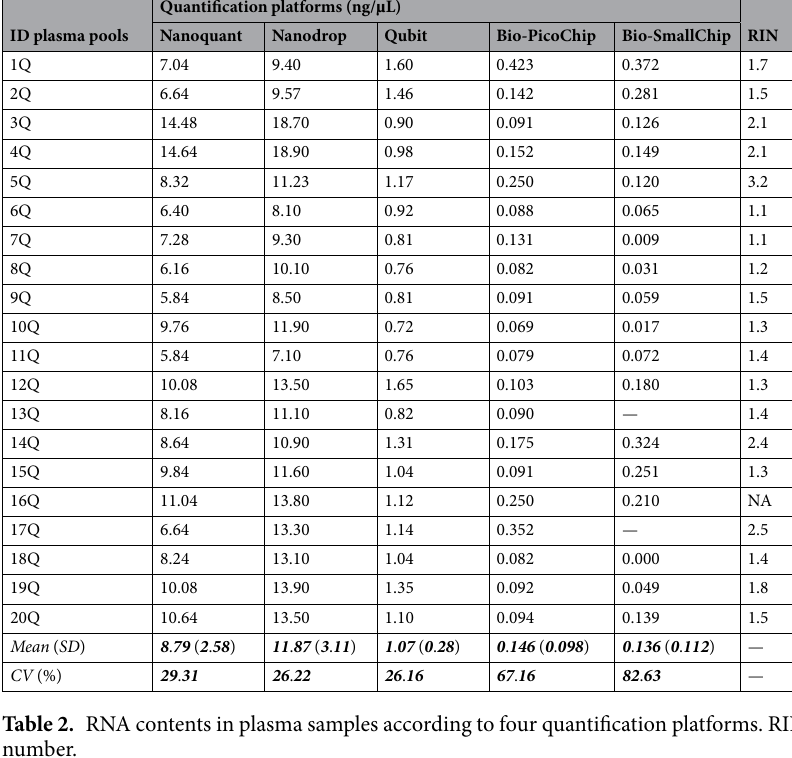
Table 2. RNA contents in plasma samples according to four quantification platforms. RIN: RNA integrity number.